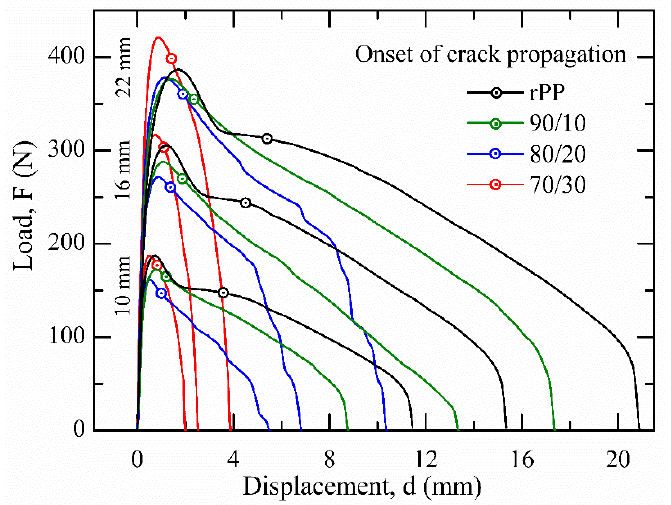
Figure 9. Self-similarity load vs. displacement (F–d) curves of analyzed materials using three different ligament lengths.